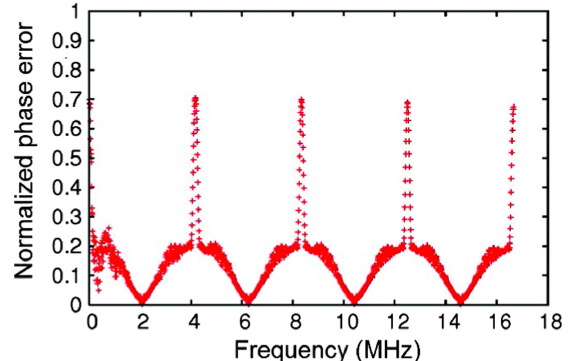
FIG. 12. Normalized phase error amplitude vs jitter frequency after filtering by recombination scheme and main beam accel- eration structures. The incoming phase error has a white noise distribution with amplitude normalized to unity.